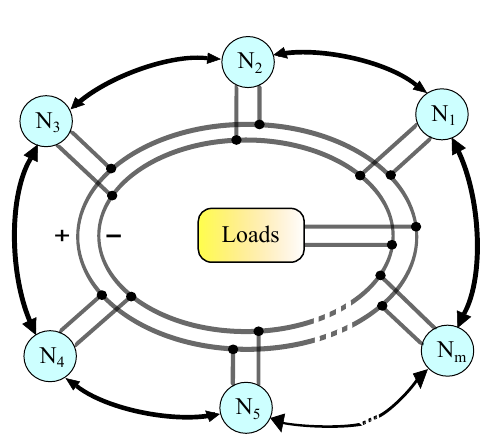
Figure 4. Microgrid: grey lines represent Power Grid, black arrows represent Information Network, circles represent